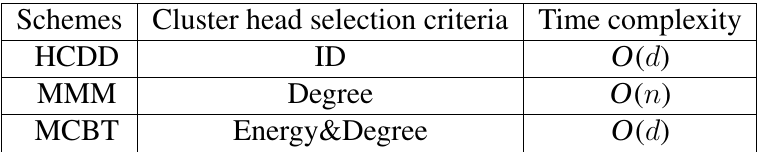
Table 1. Three clustering schemes in